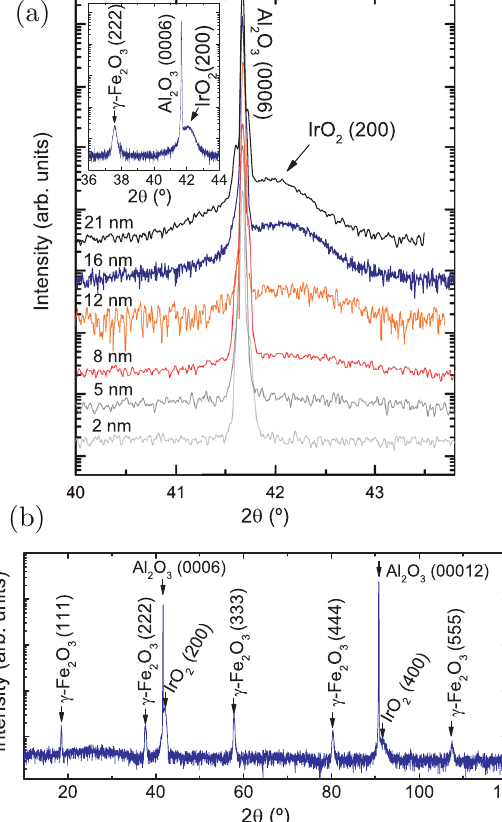
Figure 1. ( a ) Symmetric 2 θ / ω diffraction patterns around the (0006) Al 2 O 3 Bragg peak. Inset: longer- range measurement for the sample with a 16 nm-thick IrO 2 layer, including the (222) diffraction peak of γ − Fe 2 O 3 ; ( b ) Wide-range symmetric 2 θ / ω XRD scan for the sample with a 16 nm-thick IrO 2